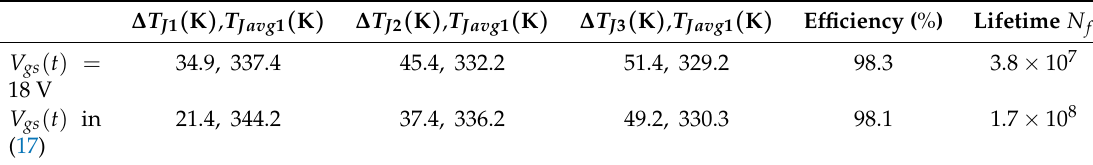
Table 8. Lifetime estimation and system efficiency for case 1.